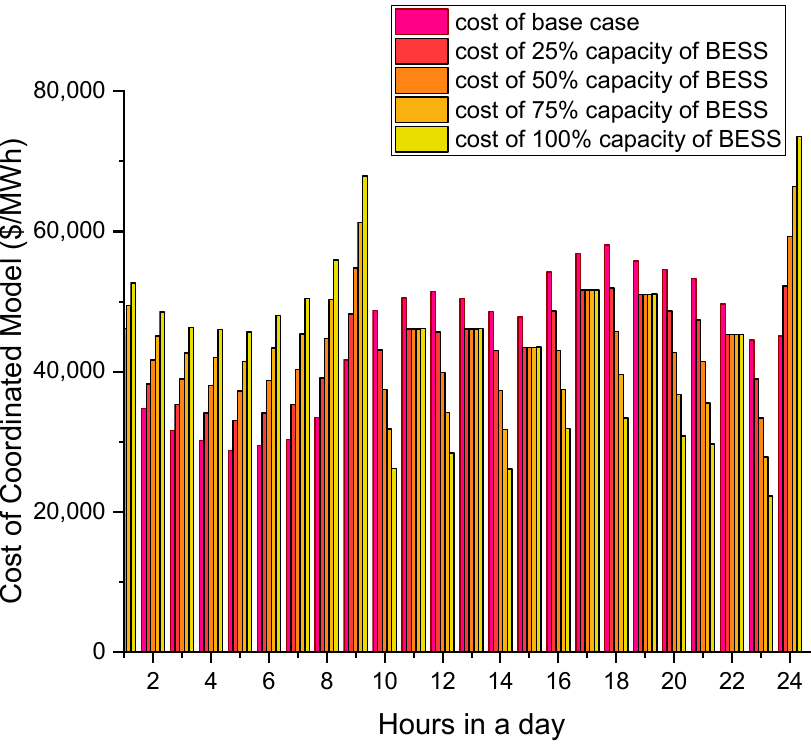
Figure 4. Cost of Operation due to Coordinated Model with different